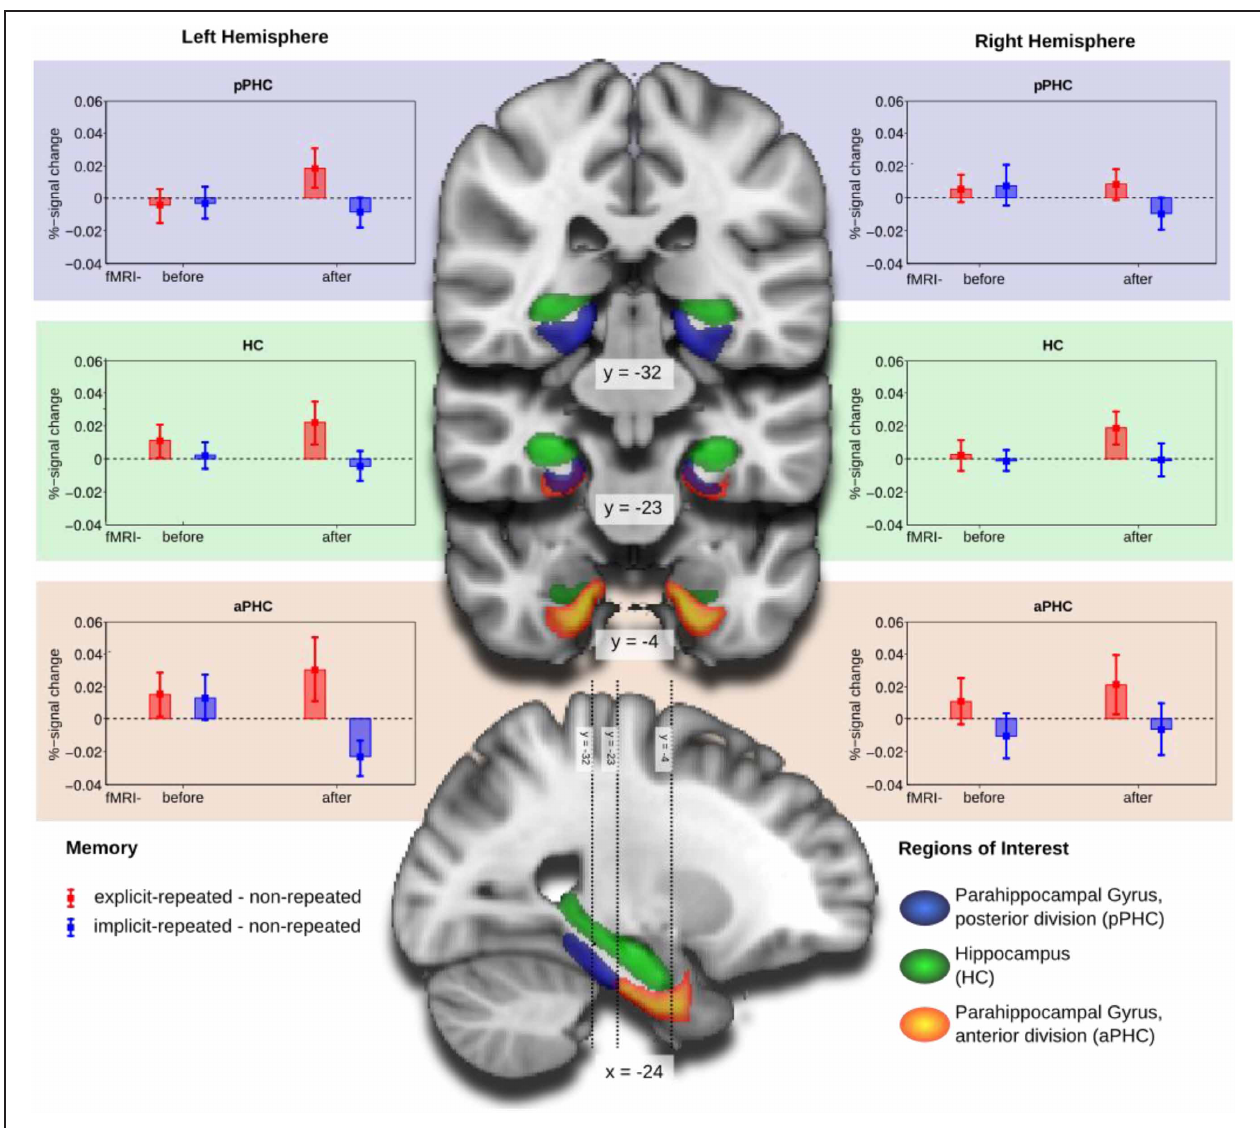
FIGURE 3 | Group mean and standard error of percent-signal-change of the memory contrasts explicit-repeated minus non-repeated displays (red) and implicit-repeated minus non-repeated displays (blue) for the regions of interest (ROI): parahippocampal gyrus, posterior division (aPHC; upper row), Hippocampus (HC; middle row),